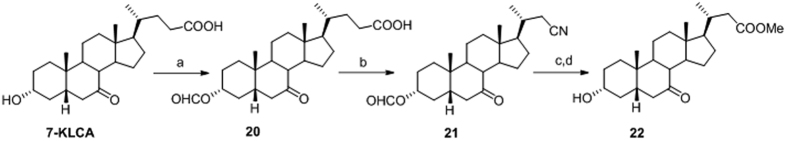
Preparation of 7-keto-norLCA methyl ester (22).Reagents and conditions: (a) HCOOH, HClO4; (b) TFA, trifluoroacetic anhydride, NaNO2; (c) KOH 30% in MeOH/H2O 1:1 v/v, 66% over three steps; (d) p-TsOH, MeOH dry, quantitative yield.